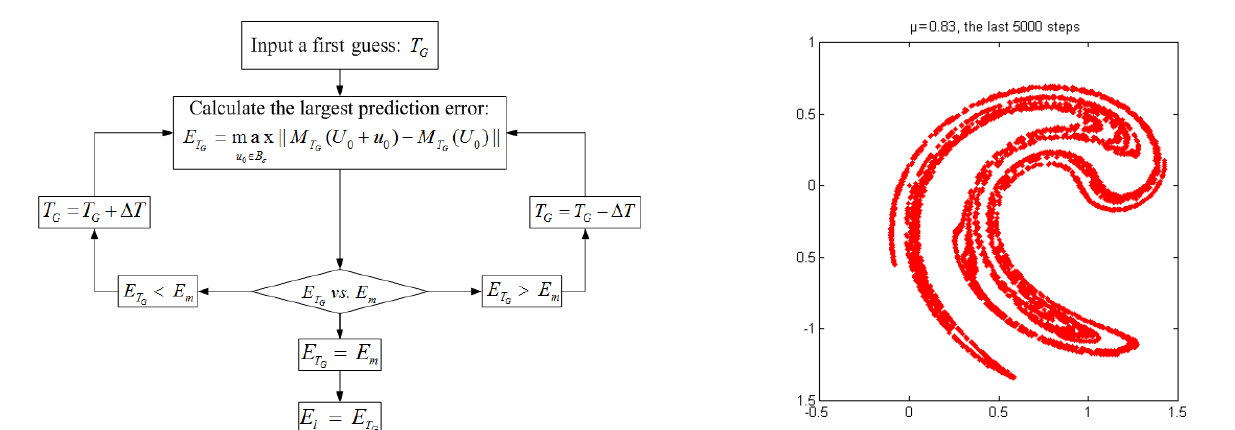
Figure 1. Flow chart of solving the LBMPT.